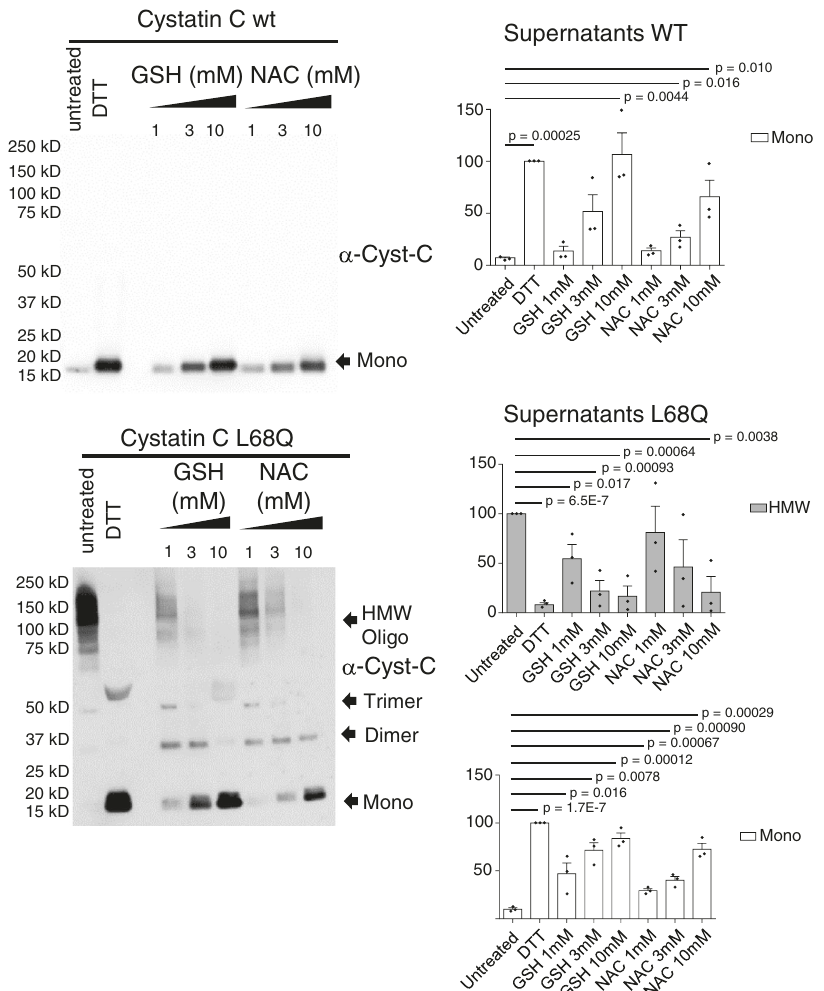
Fig. 2 Glutathione and N-acetylcysteine impairs oligomerization of secreted cystatin C L68Q. Supernatants were incubated in the presence of the indicated concentrations of glutathione or NAC for 1 h at 37 °C. Samples were mixed with 2% SDS without reducing agents prior to electrophoresis, and protein levels were detected by anti-cystatin C antibody and amounts of monomeric hCC (Mono) or high-molecular- weight hCC species (HMW) were quantitated. No HMW fraction was detected in supernatants from HEK-293T cells stably expressing hCC WT ( N = 3 independent experiments; one-tailed student t test; indicated p values were less than 0.05, without correction for multiple testing, with respect to untreated). Bars are means, error bars represent standard deviation. Gel images for replicate experiments are shown in Supplementary Fig.